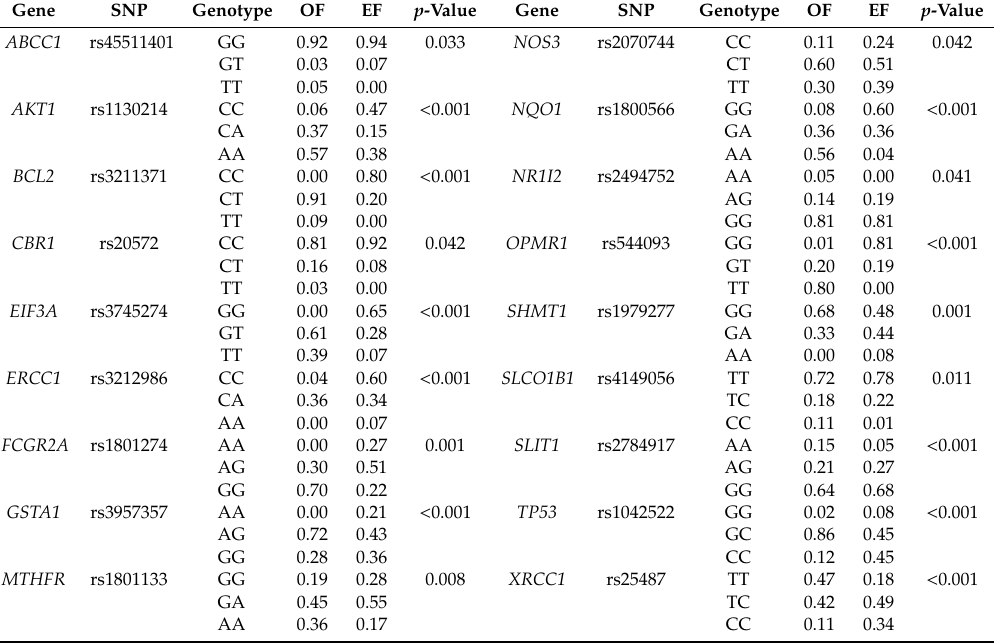
Table A1. SNPs with variant frequencies di ff erent in the study cohort in comparison with 1000 genomes project corresponding set. Chi Squared test with False Discovery Rate penalization was employed for comparison with Iberian Population in Spain data from 1000 genomes project phase